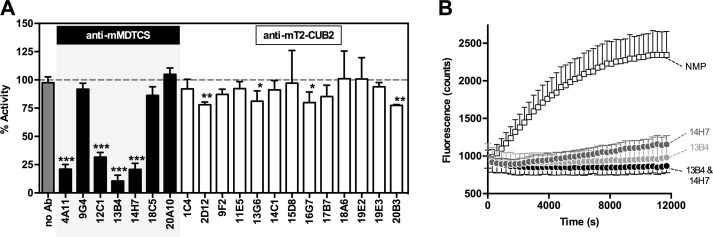
A subset of anti-mMDTCS mAbs inhibit plasma mADAMTS13 activity.The effect of anti-mADAMTS13 mAbs on the proteolytic activity of plasma mADAMTS13 was tested in vitro using the FRETS-VWF73 assay. (A) All anti-mADAMTS13 mAbs, both anti-mMDTCS and anti-mT2-CUB2 mAbs, were tested. For each condition, the activity of plasma mADAMTS13 was calculated using a calibration curve of 2.5%, 5%, 10% and 15% NMP. (B) Time profile of the cleavage of the FRETS-VWF73 substrate by plasma mADAMTS13, in the absence or presence of mAbs 13B4 and/or 14H7. Error bars represent the SD of at least three independently performed experiments.